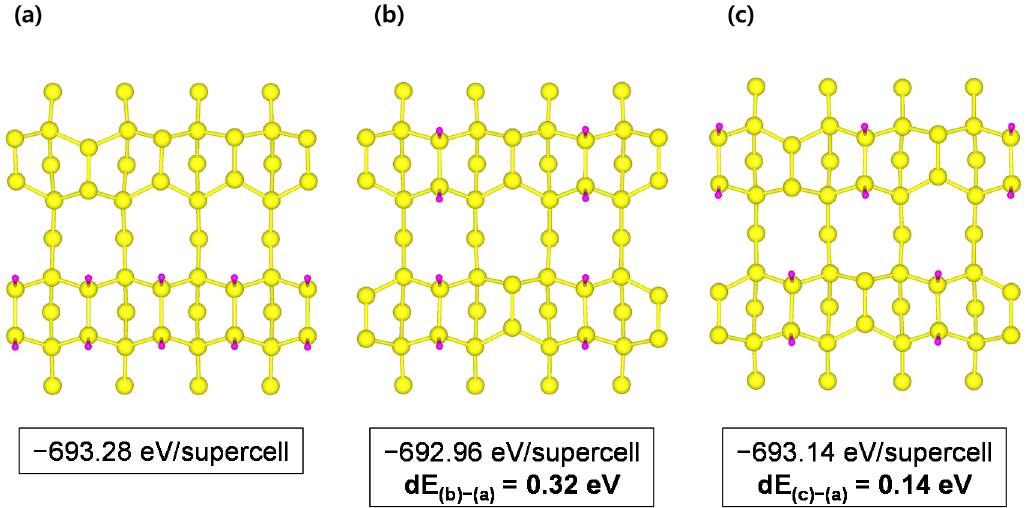
Figure 1. Density functional theory (DFT) calculation results describing most probable hydrogen configurations on top-layer of the H-50% covered Si(001) surface. Configuration ( a ): all adsorbed hydrogens are in close to each other. Configuration ( b , c ): all of the two closest hydrogens are far away from the other two closest hydrogens.